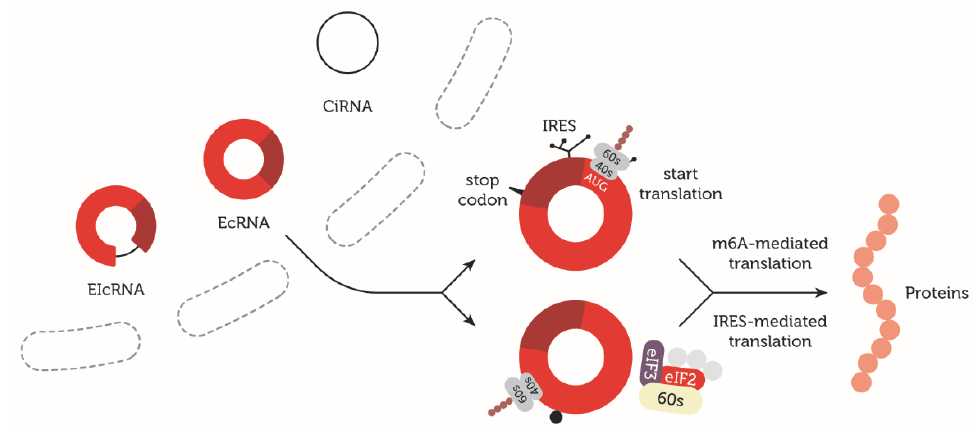
Figure 1. circRNAs can be classified based on their origin as exonic (EcRNA), intronic (CiRNA), and exon-intron (EIcRNA) transcripts. EcRNAs are mostly exported from the nucleus to the cytoplasm, and some can serve as a template for protein synthesis. In eukaryotic cells, two potential mechanisms of the cap-independent translation of circRNAs are proposed: the Internal Ribosome Entry Site (IRES) and N 6 -methyladenosines (m 6 A). In the cap-independent mechanism of translation initiation, a non-canonical eIF4G protein needs to recognize the IRES to initiate eIF4 complex assembly in order to initiate the translation. Translation initiation with the presence of m 6 A requires YTH domain-containing family protein 3 (YTHDF3), an m 6 A reader protein that can directly interact with eIF4G2, which recognizes IRESs and initiates the eIF4 complex assembly.